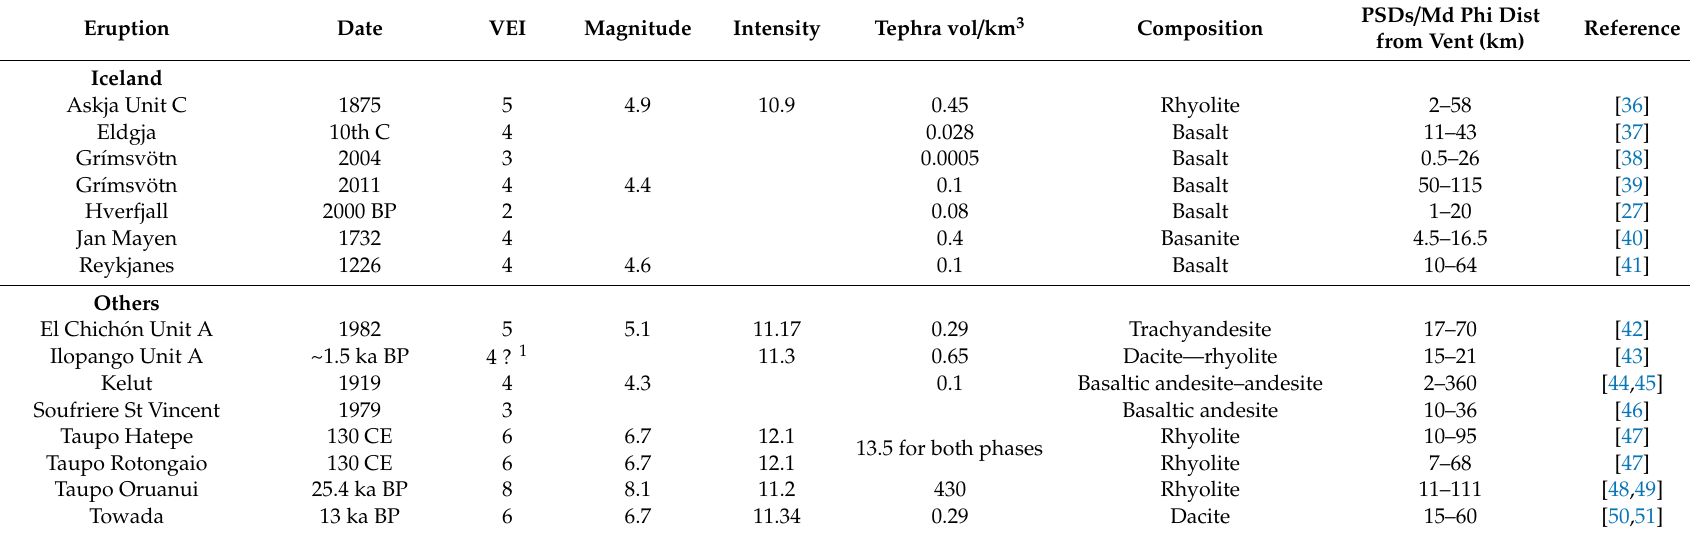
Table 1. Details of hydromagmatic eruptions. VEI (Volcanic Explosivity Index), magnitude and intensity details come from references shown, the LaMEVE database [34] and the Global Volcanism Program catalogue of Holocene eruptions